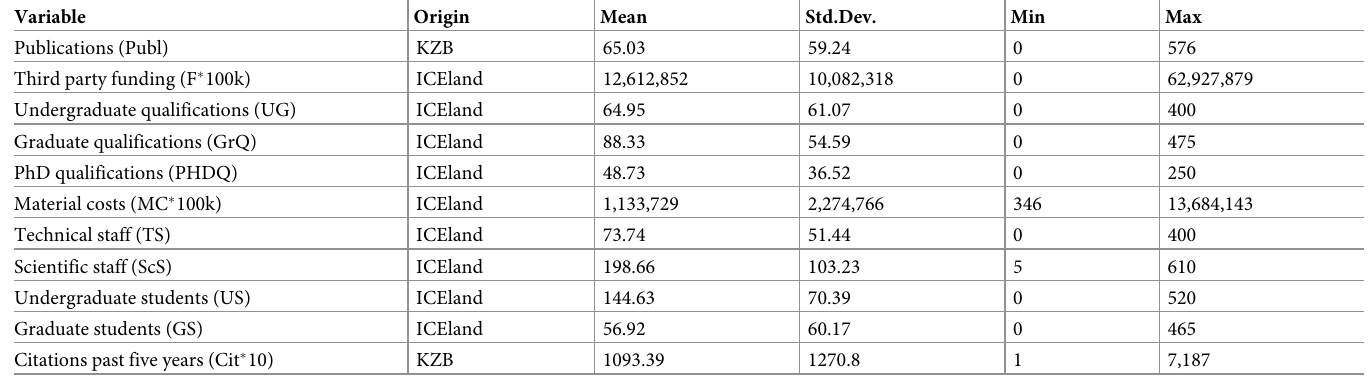
Table 3. Descriptive statistics for the pooled sample before